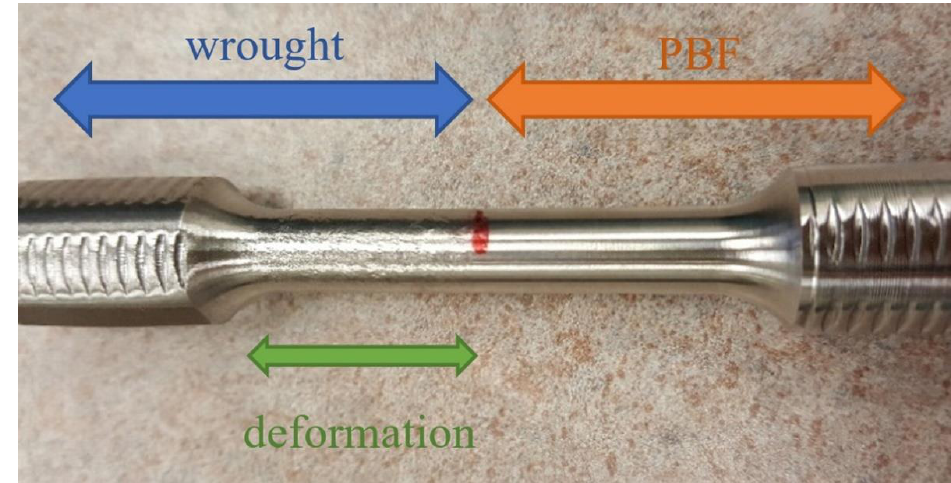
Figure 5. SS316L (PBF/wrought) torsion specimen post-failure.